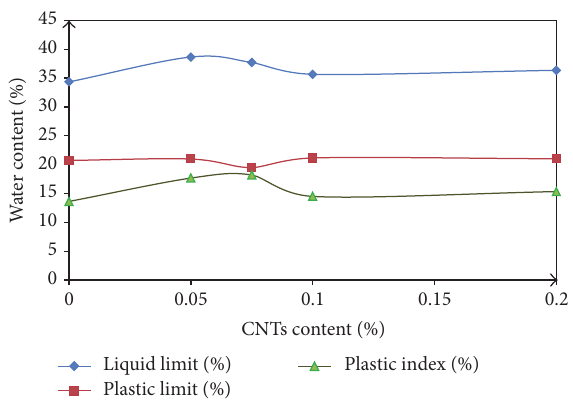
Figure 13: Effect of MWCNTs on LL, PL, and PI.